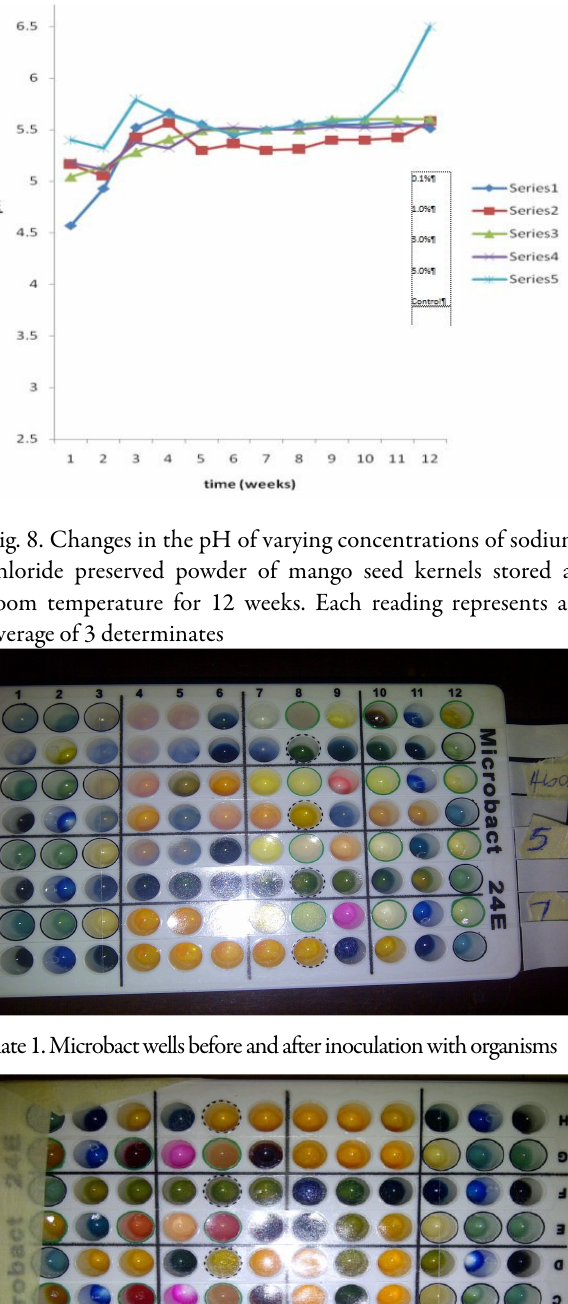
Fig. 7. Changes in the pH of varying concentrations of citric acid preserved powder of mango seed kernels stored at room temperature for 12 weeks. Each reading represents an average of 3 determinates